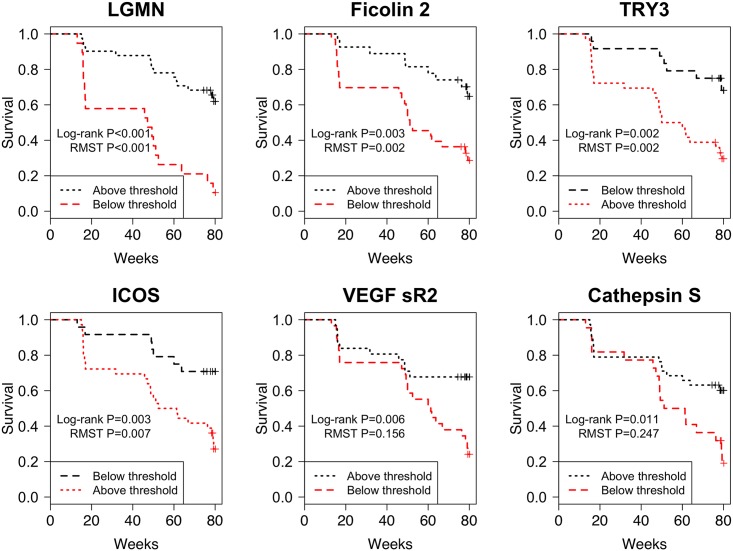
Kaplan-Meier curves showing progression free survival for IPF patients with baseline biomarker levels above or below the identified thresholds for 6 analytes best able to predict disease progression; these biomarkers are related to immune activation, protease function or angiogenesis.